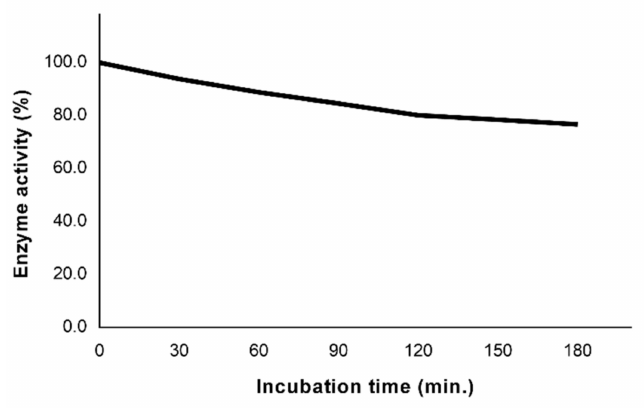
Figure 4. The residual laccase activity after incubation of laccase using a water